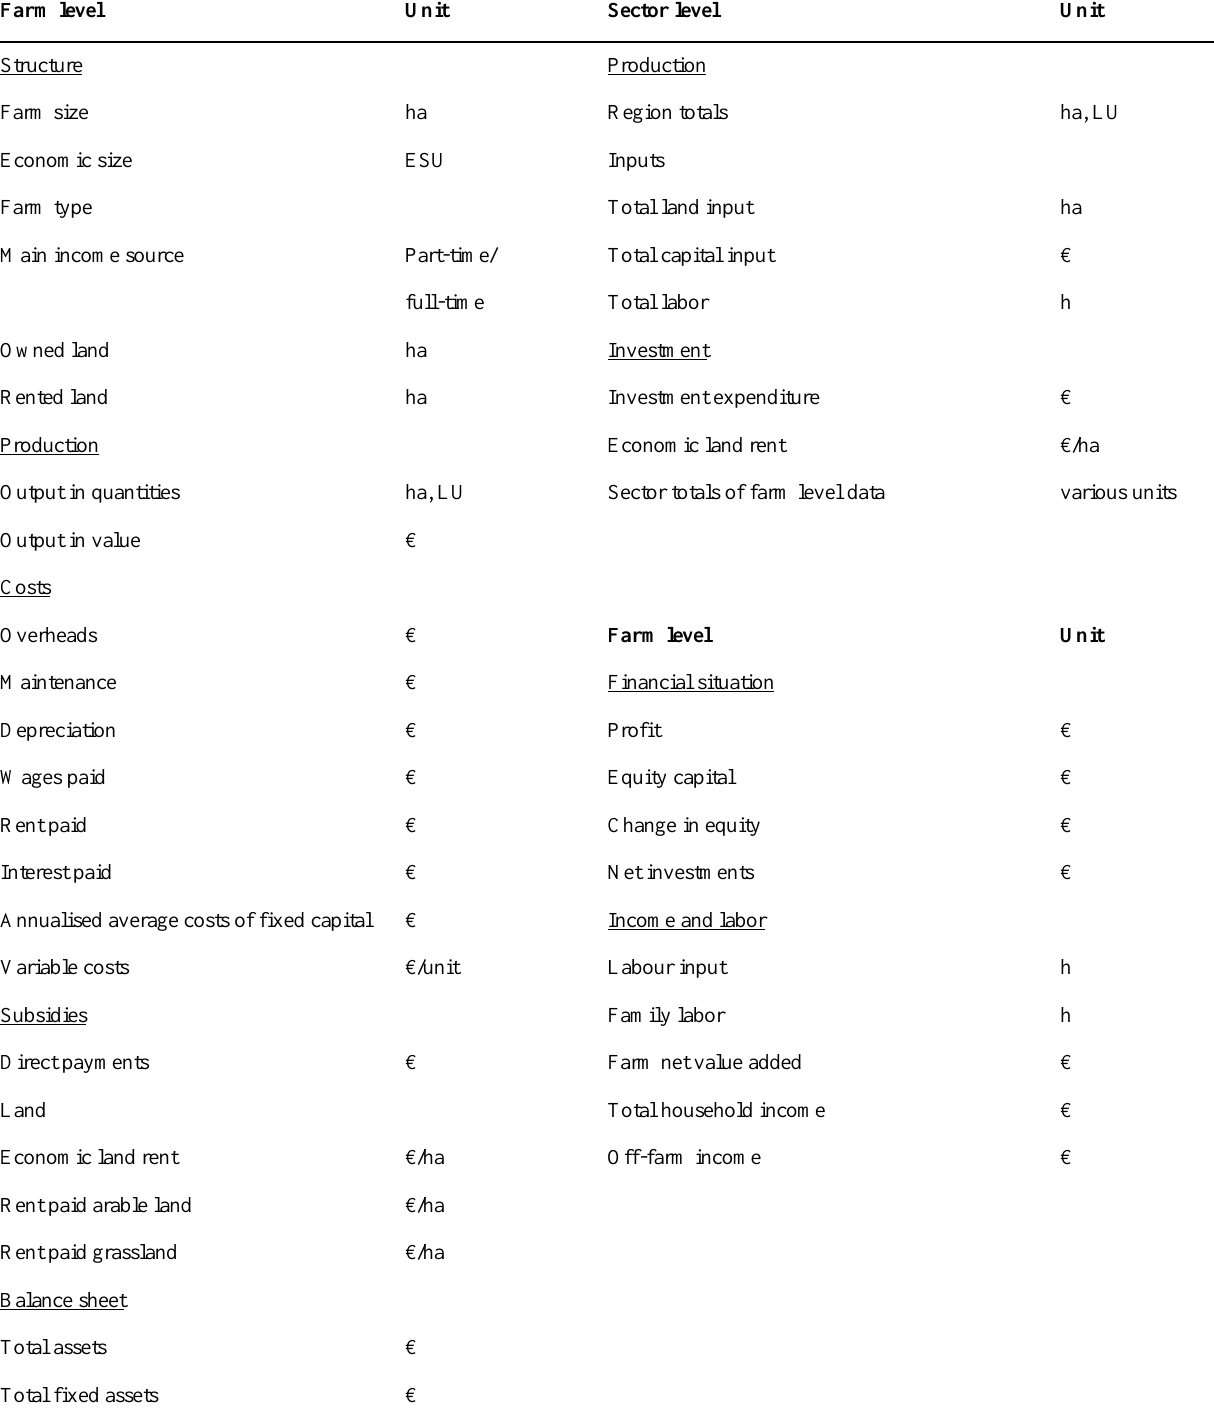
Table 1. Data output at farm and sector